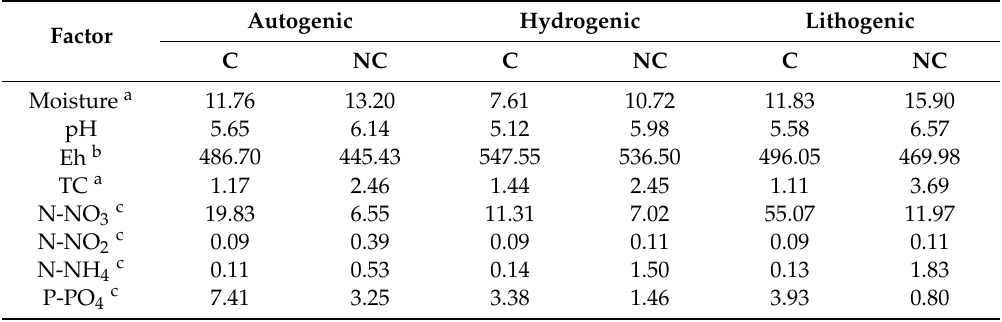
Table A1. Averaged values of chemical parameters in the three genetic types of soils (C-cultivated, NC- control, non-cultivated